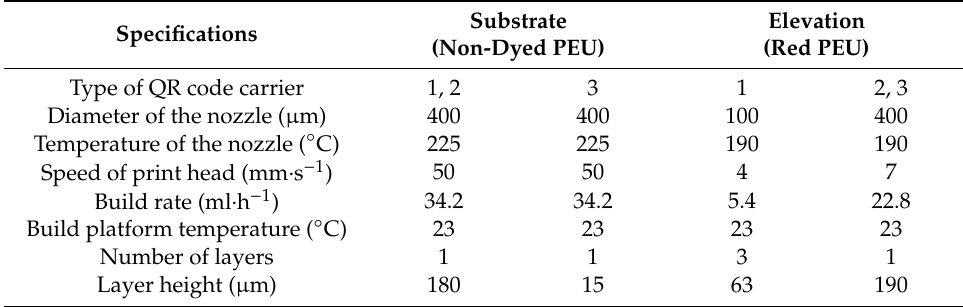
Table 1. Printing instructions for Ultimaker 3 to produce the three di ff erent prototypes of QR code carriers based on